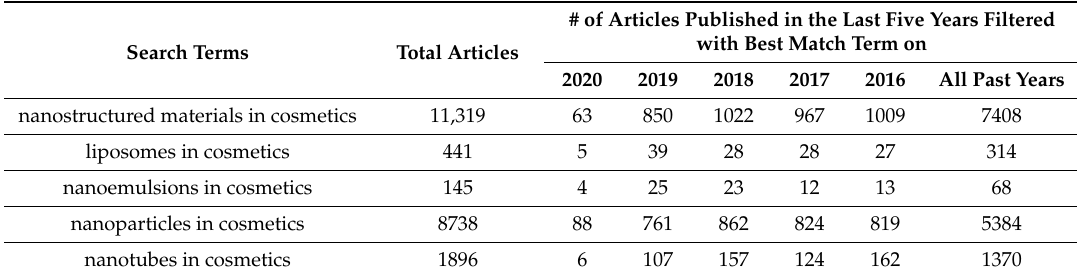
Table 2. The search terms and data statistics obtained from PubMed.